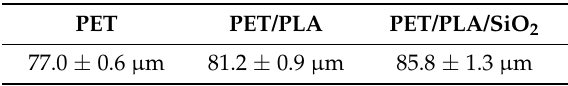
Table 1. Thicknesses of the non-coated polyethylene terephthalate (PET) film and PET films coated by electrospun polylactide (PLA) fibers and electrosprayed silica (SiO 2 )